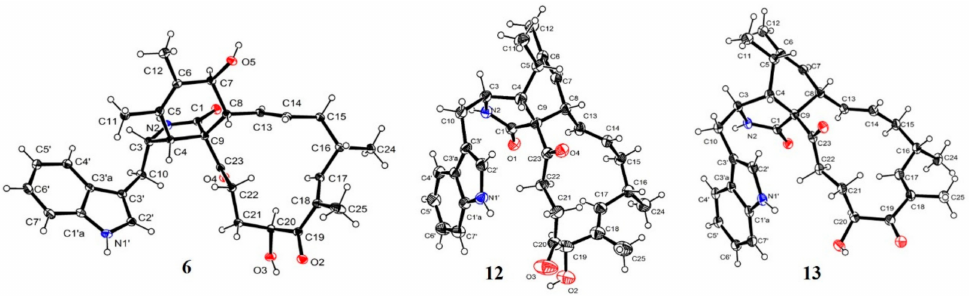
Figure 3. X-ray structures of chaetoglobosin E ( 6 ), penochalasin G ( 12 ), and armochaetoglobin G ( 13